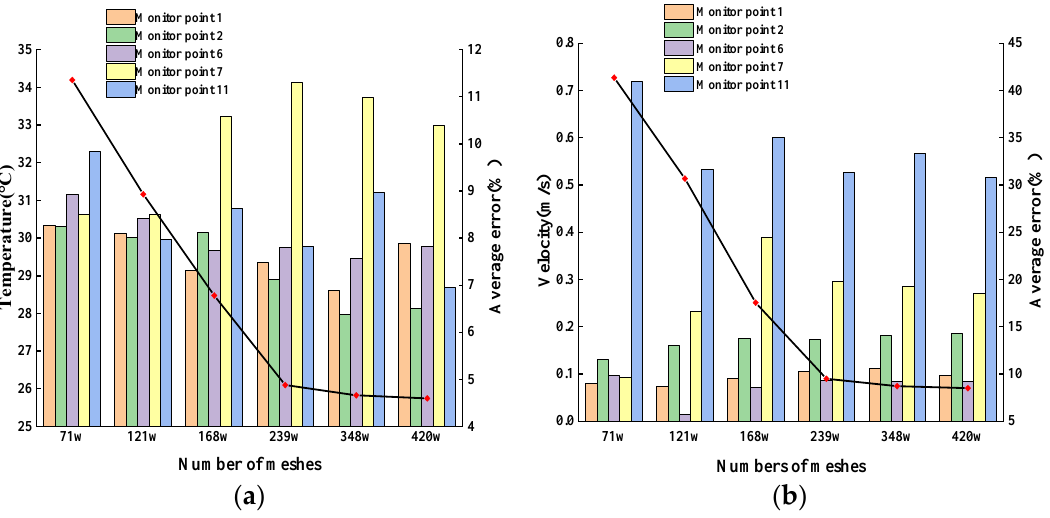
Figure 5. Grid independence verification. ( a ) Temperature verification. ( b ) Wind speed verification.